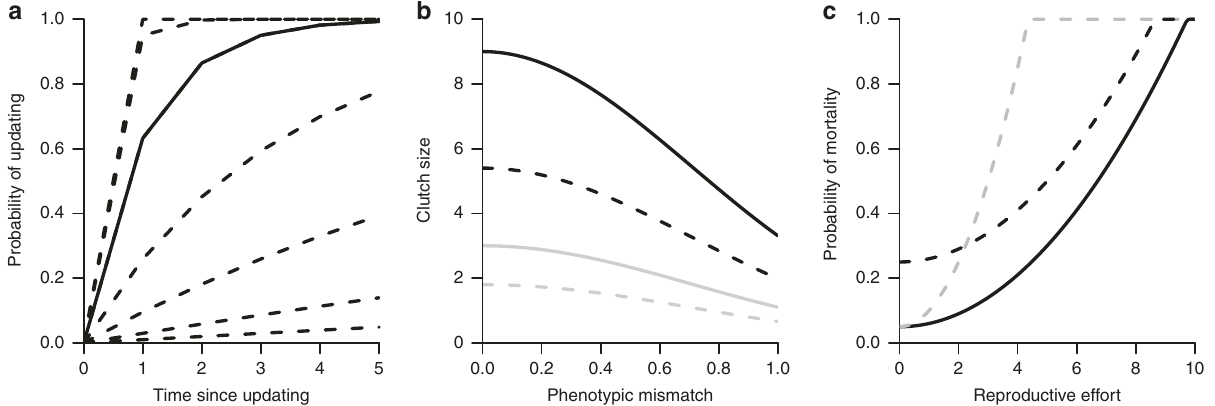
Fig. 1 Model assumptions. a Probability of updating increases with time since last updating, but the rate of increase is regulated by u . Solid line is for u = 1, dashed lines above are for larger values of u = {3,10} and dashed lines below are for lower values of u = {0.3, 0.1, 0.03, 0.01}. b Clutch size, c , decreases with phenotypic mismatch, m , with the environment. Black lines are for high reproductive effort r = 9, grey indicates lower reproductive effort r = 3. Solid lines indicate clutch size when the individual did not update their phenotype, while dashed lines indicate the lower clutch size when individuals update due to costs of updating, κ = 0.4. c Mortality probability increases with reproductive effort, r . Solid line shows the probability of mortality when the individual has no phenotypic mismatch and ρ = 0.01, the black dashed line shows the mortality for individuals that mismatch their environment by 0.2 and the grey dashed line indicates mortality for when cost of reproduction, ρ , is increased to 0.05 (see Supplementary Note